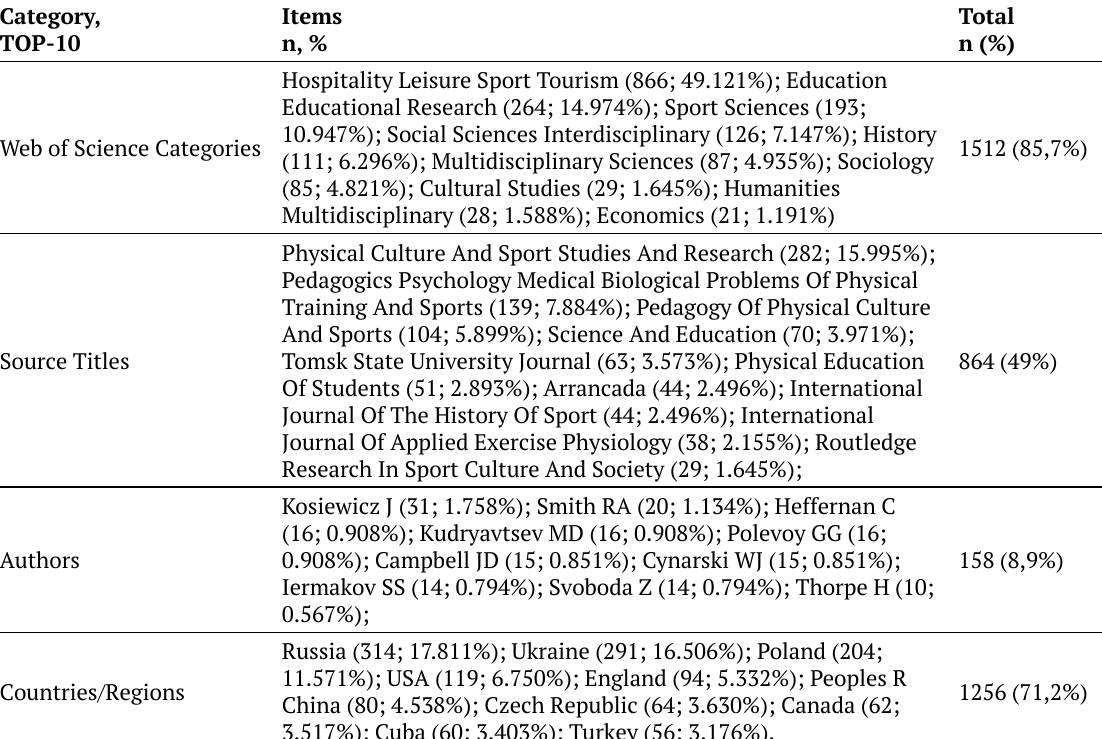
Table 1. The results of the analysis of the search query on the basis of Web of Science Core Collection (n